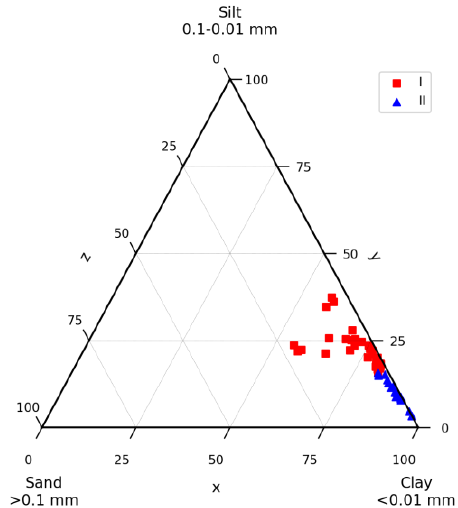
Figure 15. Ternary diagram of grain size composition (%) in the stratigraphical Unit I, 0–290 cm (red dots), and Unit II, 290–444 cm (blue dots) from core AMK-5194, the Central Deep of the Barents Sea.